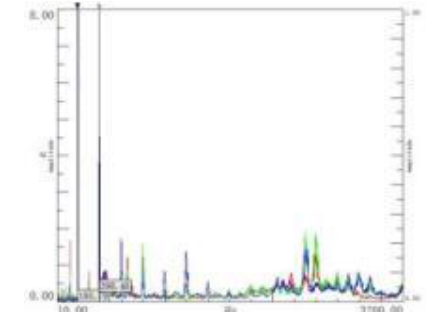
Figure 2 Vibration frequency at the front part of a 15 kg gasoline helicopter